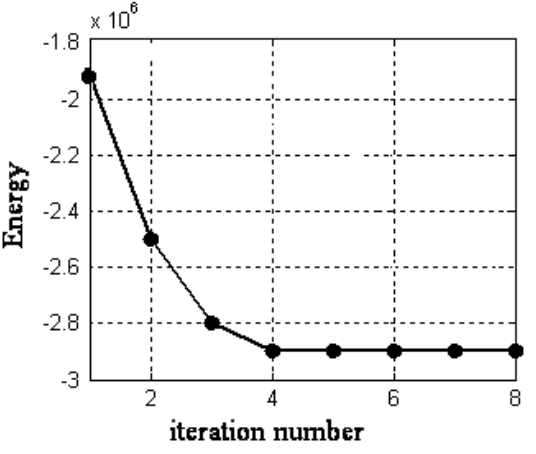
Figure 5. Energy variation against the number of iterations during the HNN optimization process.